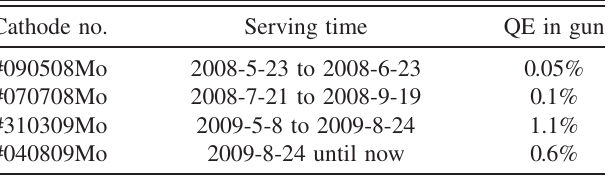
TABLE I. Cathodes serving in SRF gun.